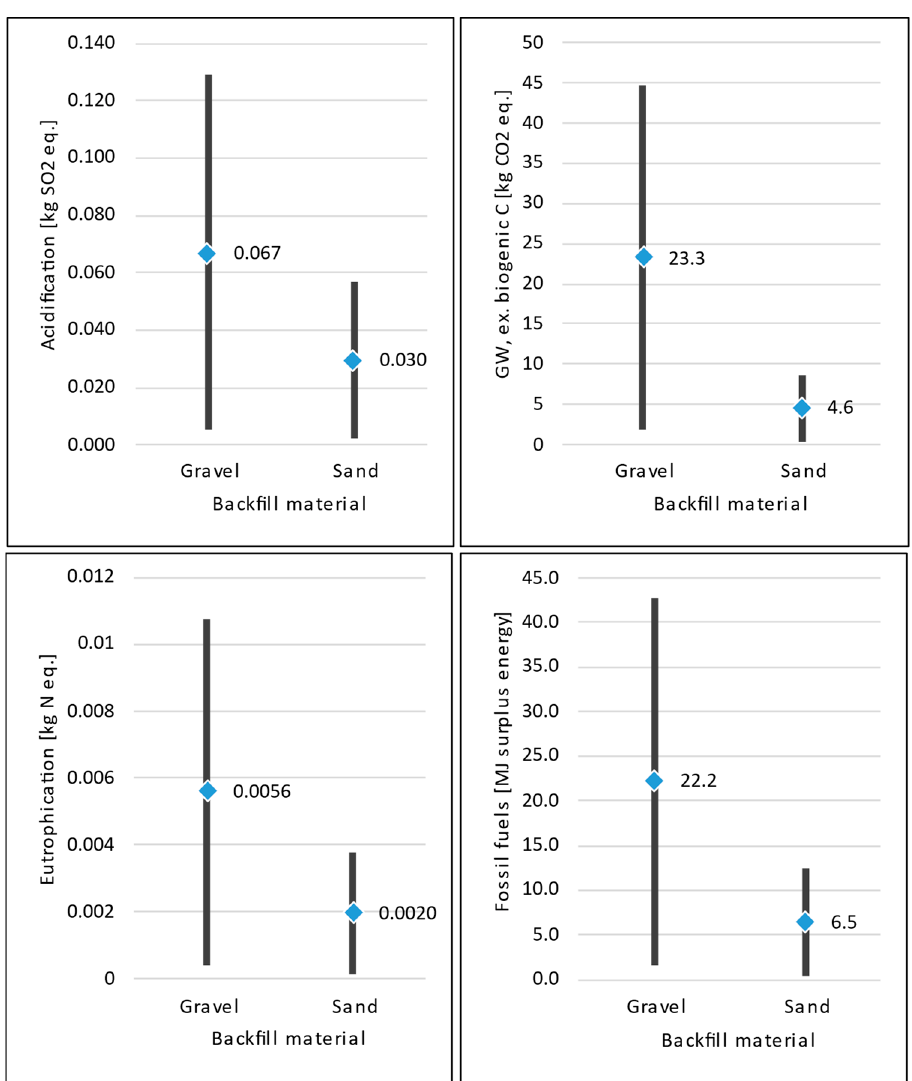
Figure 5. Traci 2.1 midpoint impact of backfill material choice showing gravel with higher impact than sand by more than 2:1. Diamonds represent the midpoint, and the black bars represent the range.